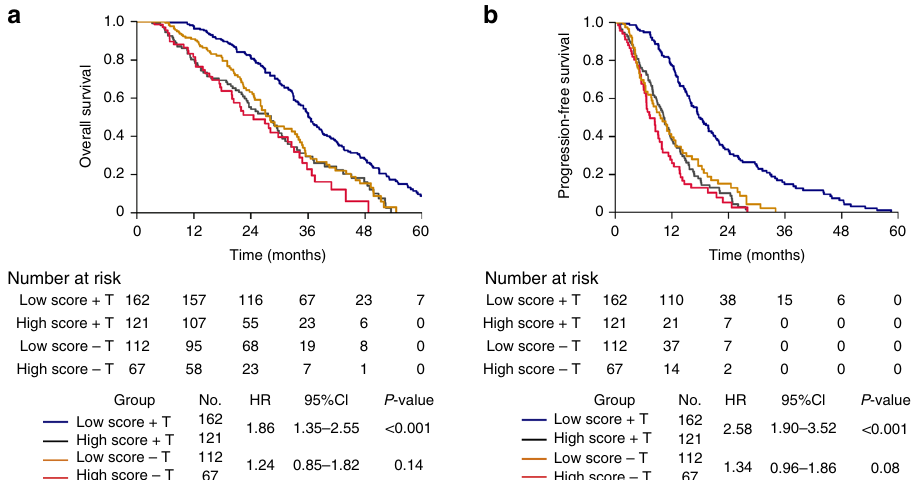
Fig. 5 Kaplan – Meier survival analysis for patients with HER2 + MBC receiving only chemotherapy cohort and validation cohorts according to the 4-miRNA signature and trastuzumab treatment. a Overall survival. b Progression-free survival. P -values were calculated with the two-sided log-rank test. T